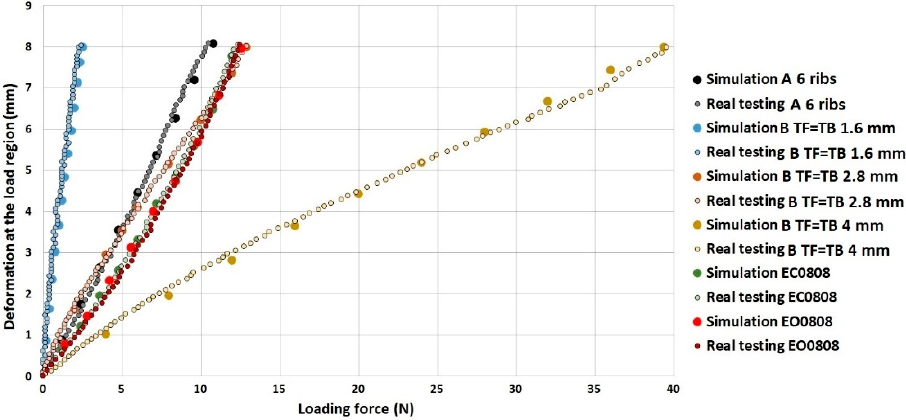
Figure 13. Dependence of loading force on deformation for finger without filling for simulated and real tests.